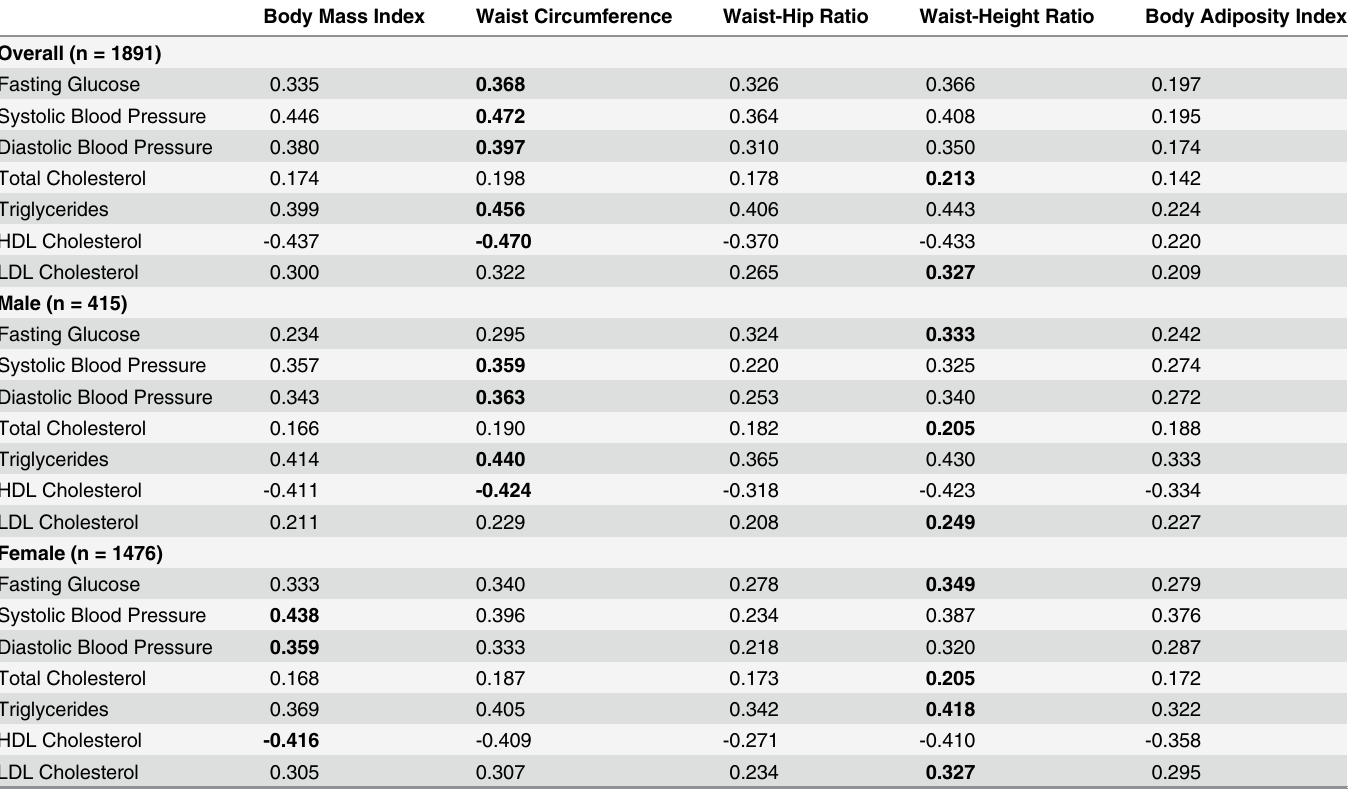
Table 2. Spearman Correlation Coefficient between Anthropometric Indices and Cardiovascular Disease Risk Factors. Body Mass Index